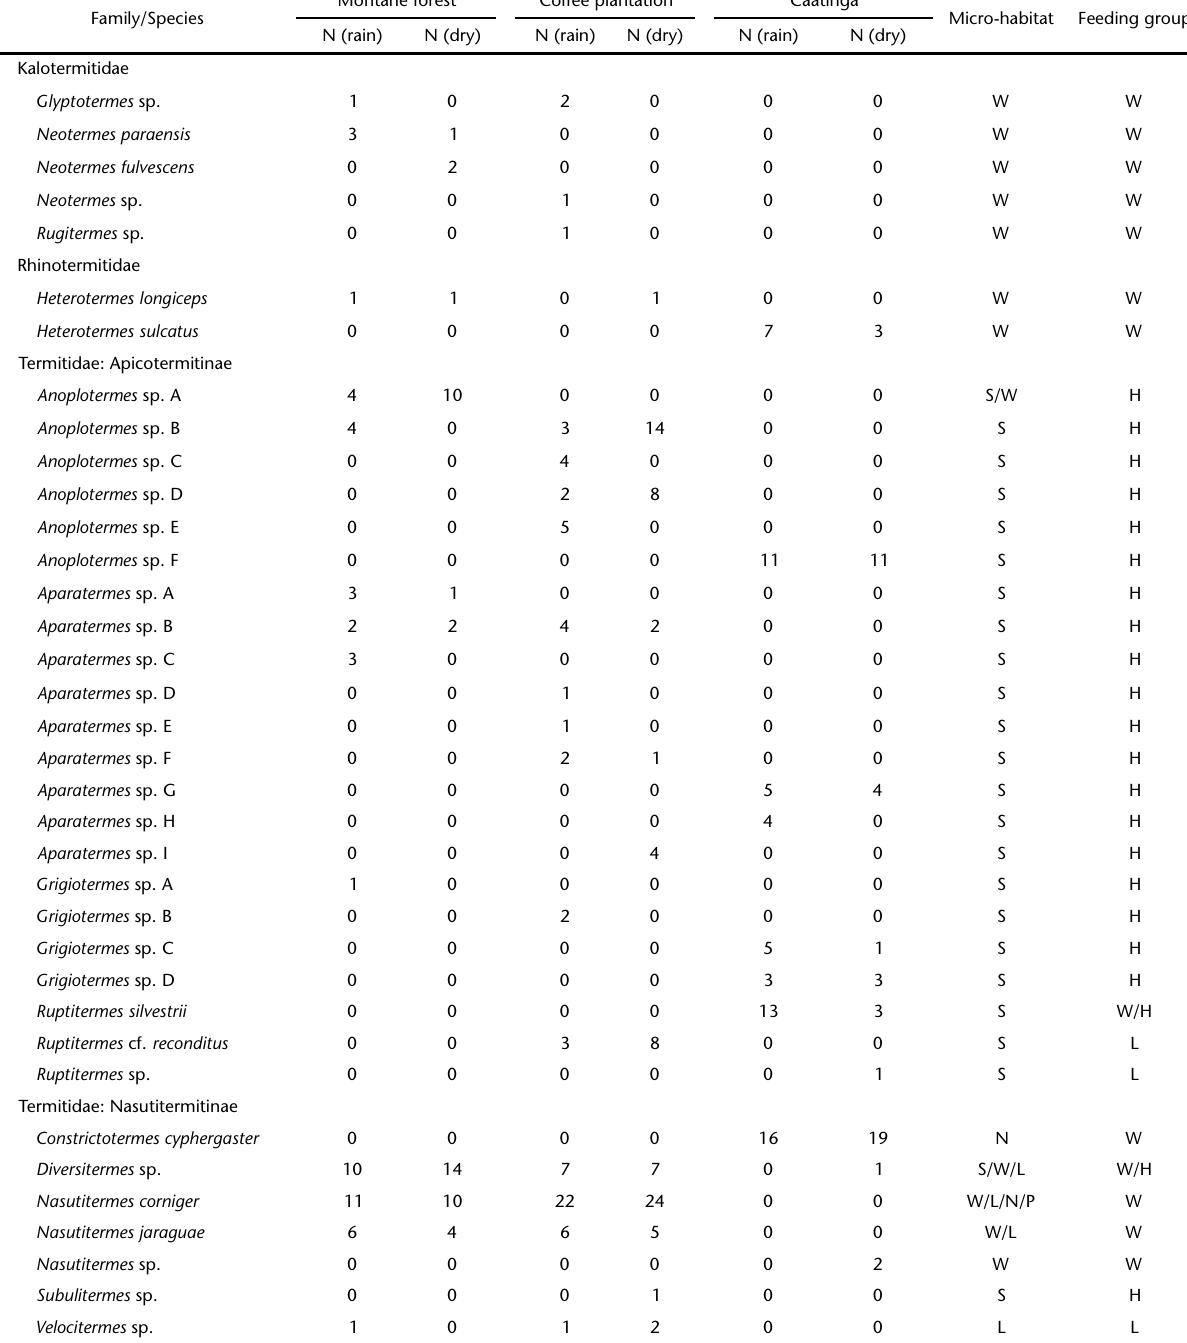
Table 1. Observed and estimated richnesses and the numbers of termite encounters in three phytophysiognomies in the semiarid region of northeastern Brazil. N – Number of sectors in which a species was encountered. Sobs – Observed richness. C.I. – Confidence interval. Micro-habitat (W – decomposing wood, S – soil, L – leaf litter, N – nest, P – live plant). Feeding group (W – wood consumers, H – humus consumers, W/H – wood/humus consumers, L – leaf